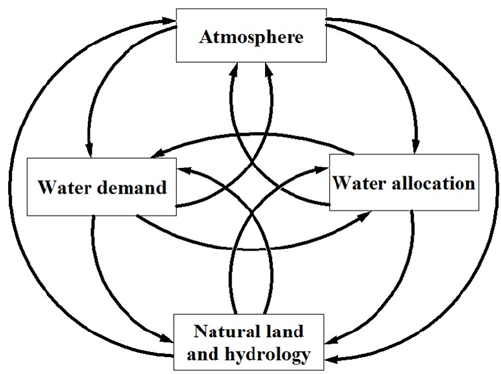
Figure 1. Water resource management as an integration of water demand and water allocation and its interactions with natural land- surface and